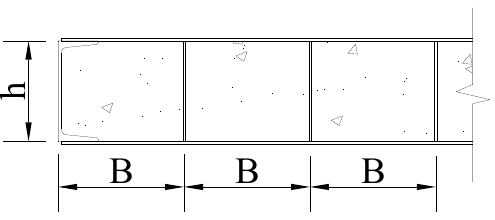
Figure 10. Schematic diagram of the aspect ratio of grille-type steel plate.